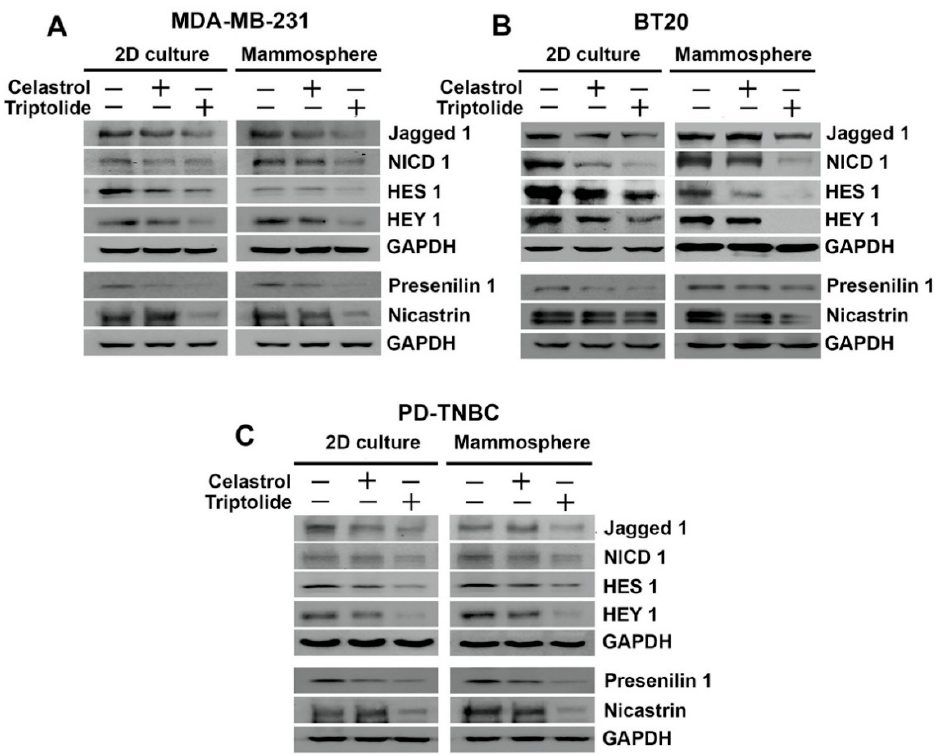
Figure 3. HSP90 inhibitors affect notch signaling in TNBC cells. Celastrol and triptolide inhibited notch signaling by decreasing the expression level of Notch ligand, Jagged-1, NICD 1, and Notch downstream target proteins HES1 and HEY1 in TNBC cells. Left panel shows blots from cells grown in 2D cell and right panel shows those from mammospheres. ( A ) MDA-MB-231 cells, ( B ) BT20 cells, and ( C ) PD-TNBC cells.